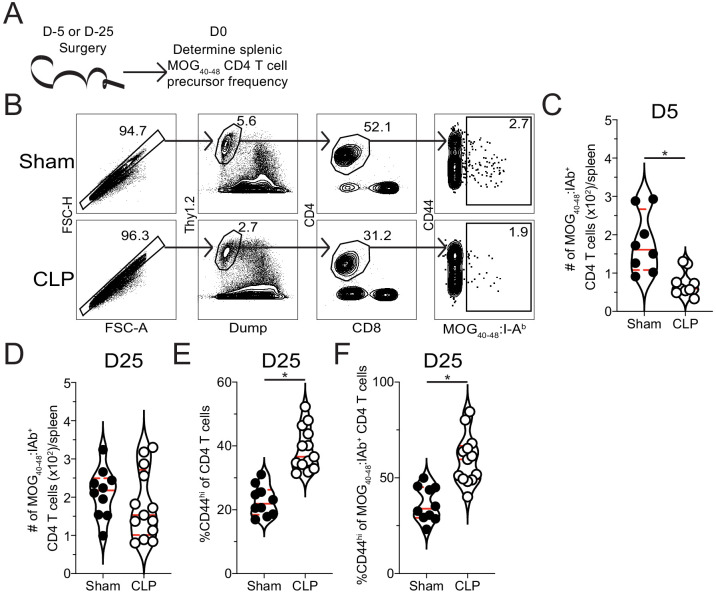
Sepsis reduces the number of naive MOG-specific CD4 T cell precursors.(A) Experimental design: C57Bl/6 mice underwent sham or CLP surgery. MOG-specific CD4 T cell precursors were enriched from the spleen 5 days after surgery via tetramer pulldown and enumerated. (B) Representative gating strategy for identifying MOG-specific CD4 T cell precursors from sham and CLP mice. Number of splenic MOG-specific CD4 T cell precursors in sham and CLP mice (B) 5 and (C) 25 days post-surgery. Frequency of antigen-experienced (CD44hi) (E) total and (F) MOG-specific CD4 T cells. Data are combined from two independent experiments with 8–13 mice per group. *p<0.05. Error bars represent the standard error of the mean.
Figure 5—source data 1.Source data for Figure 5.